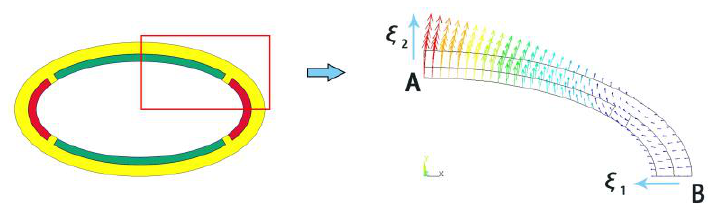
Figure 8. Displacement amplification motion of Conformal Driving Class IV FT.